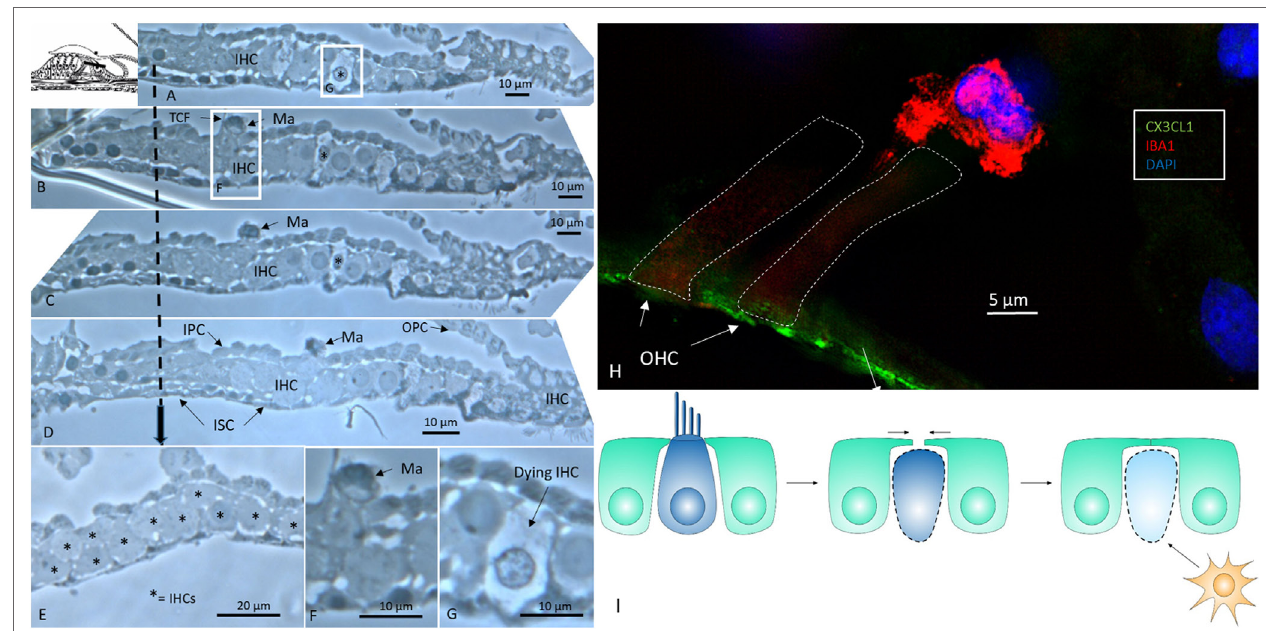
FigUre 1 | Human organ of corti (OC) contains migrating macrophages. (a–D) Horizontal serial sections (1 µm) of the apical turn of the OC dissected from a middle-aged female with normal hearing in both ears during surgery for petroclival meningioma (40). (b,F) Dendritic macrophage (Ma) with lysosomes can be seen in the corti tunnel near a degenerating inner hair cell (IHC). (e) Many IHCs (supernumerary) are present beneath the reticular lamina. (F) Framed area in panel (b) is shown in higher magnification in panel (F) . (g) Framed area in panel (a) is viewed at higher magnification in panel (g) and displays an IHC undergoing degeneration. TCF, tunnel crossing fiber; OPC, outer pillar cell; IPS, inner pillar cell; ISC, inner sulcus cell; IPhC, inner phalangeal cell (1% osmium tetroxide and toluidine blue staining). The broken arrow displays top-down sectioning. (h) Immunofluorescence of an ionized calcium-binding adaptor molecule 1 (IBA1)-IR cell associated with an outer hair cell in the OC. The reticular lamina expresses fractalkine. (i) Hypothetical representation of macrophage disposal of dying hair cells in the human OC. Hair cells retract beneath the reticular lamina and are removed by activated